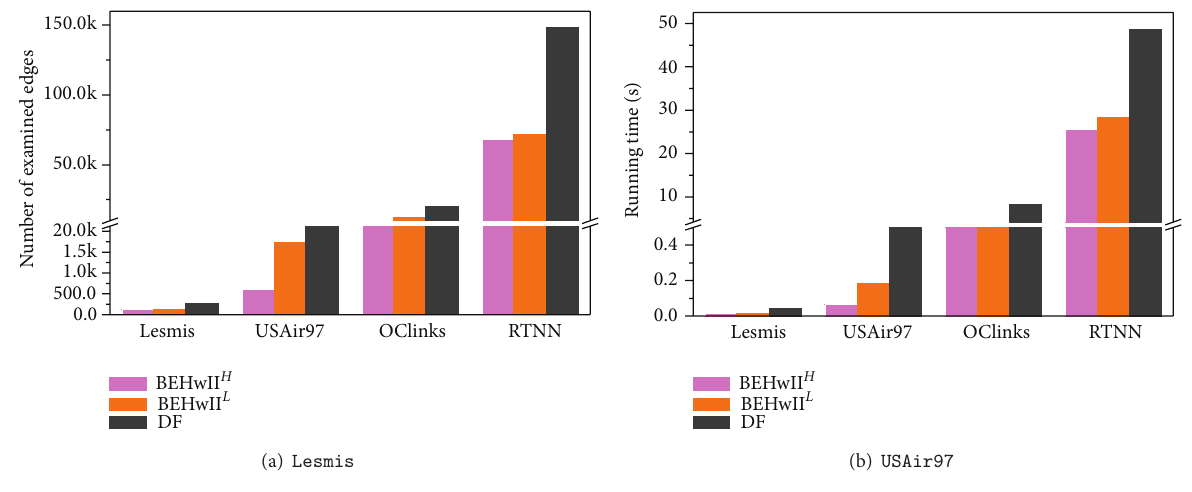
Figure 6: Comparison on efficiency.